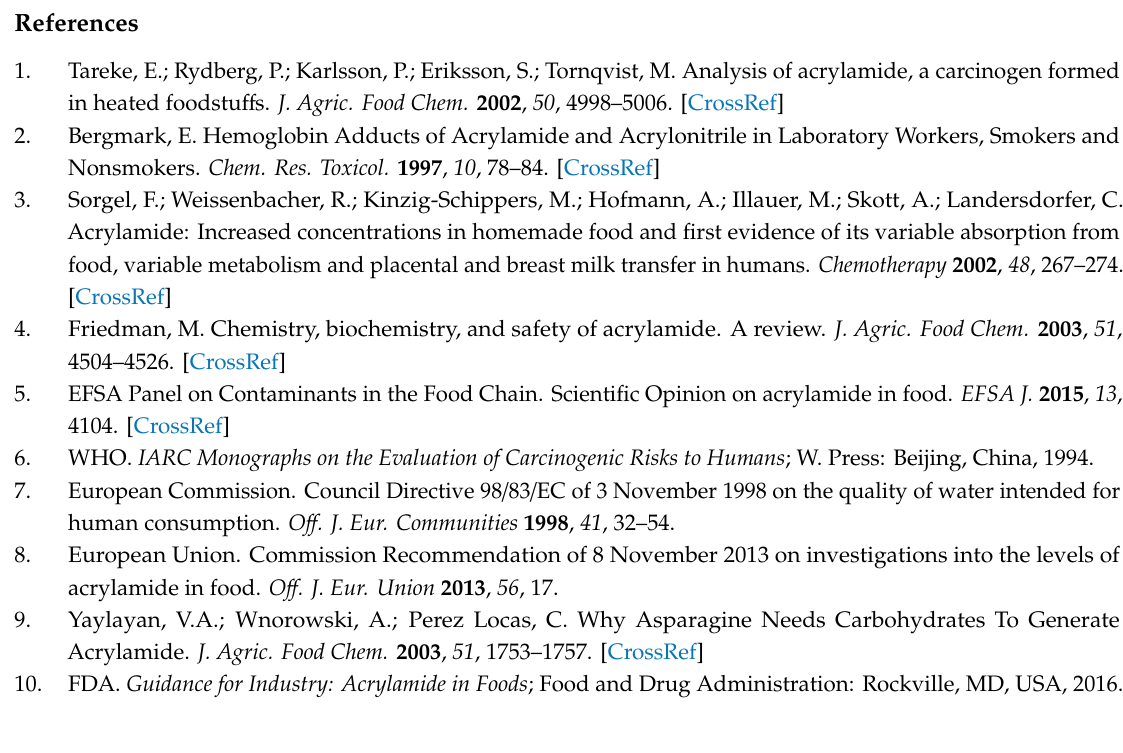
Figure S1: Chromatograms for a biscuit sample, indicating the acrylamide (AA) and deuterated acrylamide (AA-d3) retention